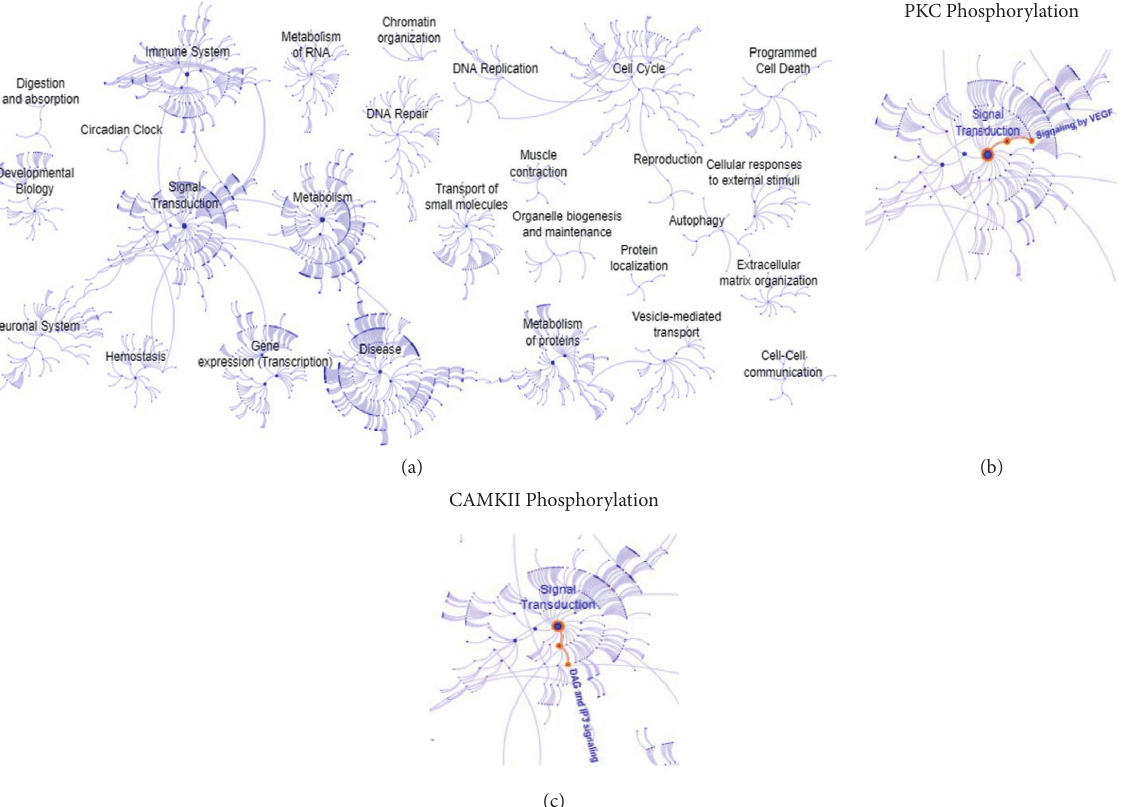
Figure 8: Characterization of metabolic pathways with the Reactome tool. (a) Metabolic pathways stored for Homo sapiens . (b) Transduction pathway turned on by PKC phosphorylation. (c) Transduction pathway by CAMKII